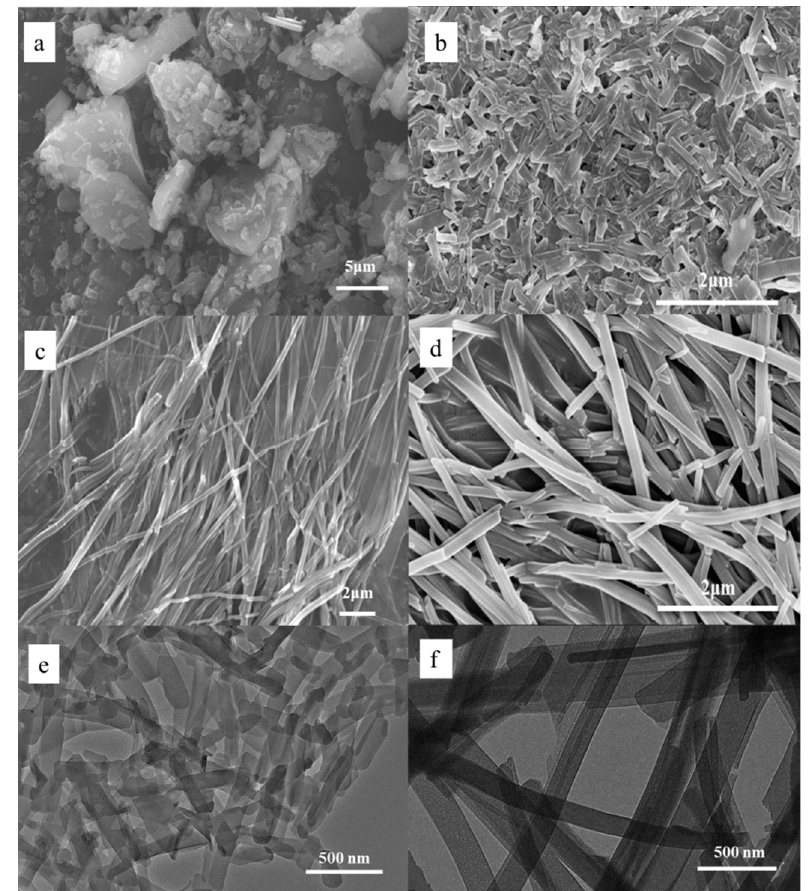
Figure 1. SEM of ( a ) untreated 5,10,15,20-tetrakis(4-carboxyphenyl)porphyrin (TCPP) powders; ( b ) hexadecyl trimethyl ammonium bromide (CTAB)-TCPP aggregates; ( c ) non-CTAB-TCPP aggregates ( d ) ethylene glycol (EG)-TCPP aggregates and TEM of ( e ) CTAB-TCPP aggregates ( f ) EG-TCPP